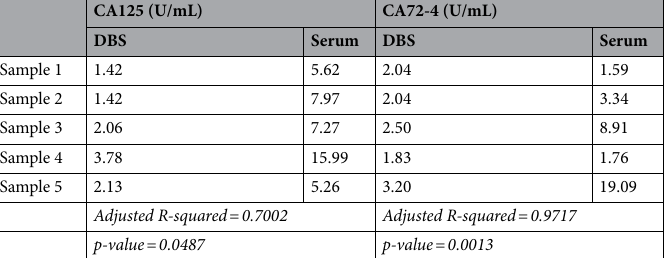
Table 2. Protein expression and correlation of protein expression of 5 matched serum and DBS samples run on single-plex ELISAs for CA125 and